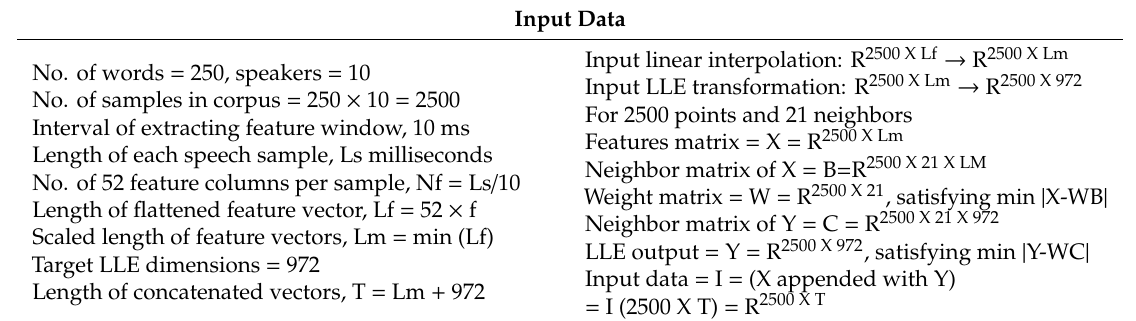
Table 1. Input data